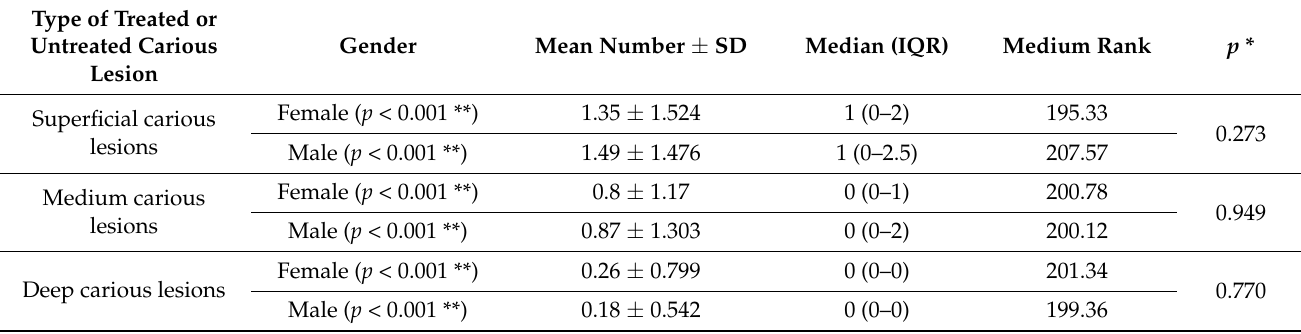
Figure 5. Distribution of superficial carious lesions (SCL), medium carious lesions (MCL), and deep carious lesions (DCL) according to the dental age of the patients (expressed in years). Table 2. Comparison between the number of superficial, medium, and deep carious lesions related to gender. Type of Treated or Untreated Carious Lesion Superficial carious lesions